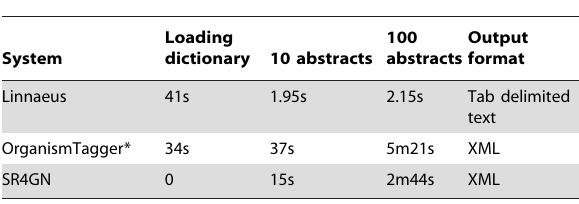
Table 4. Comparison of benchmarking time on species detection by Linnaeus, OrganismTagger and